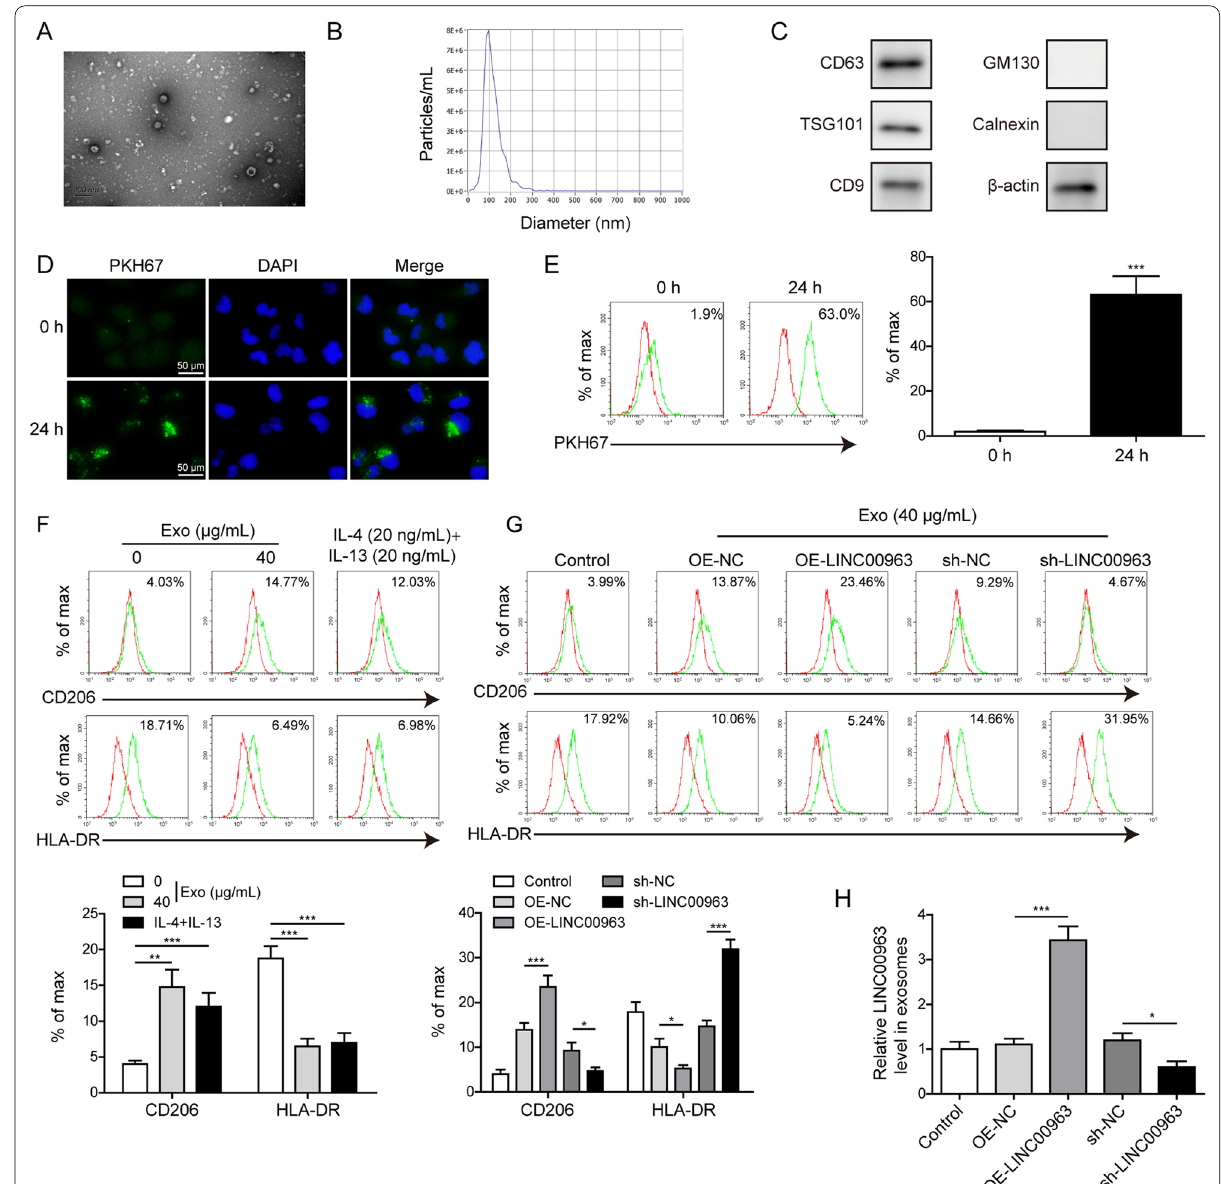
Fig. 8 LUAD cells-derived exosomal LINC00963 induced M2 macrophage polarization. Exosomes were isolated from the medium of A549 cells, observed for their morphology under TEM ( A ), measured for their size distribution by NTA ( B ), and analyzed for the expression levels of CD63, TSG101, CD9, GM130, calnexin by western blot ( C ). A549-derived exosomes were labeled with PKH67 and then incubated with macrophages. Macrophages were detected by immunofluorescence ( D ) or flow cytometry ( E ). Scale bar: 100 μm. F A549-derived exosomes 40 (µg/mL) were incubated with macrophages. Those incubated with IL-4 and IL-13 (20 ng/mL) were used as the positive control. Expression levels of CD206 and HLA-DR were examined by flow cytometry. G Exosomes isolated from indicated A549 cells were applied to macrophages. Expression levels of CD206 and HLA-DR on macrophages were examined by flow cytometry. H Exosomes were isolated from indicated A549 cells and examined for LINC00963 expression in exosomes by RT-qPCR. * P < 0.05, ** P < 0.01, and ***P <